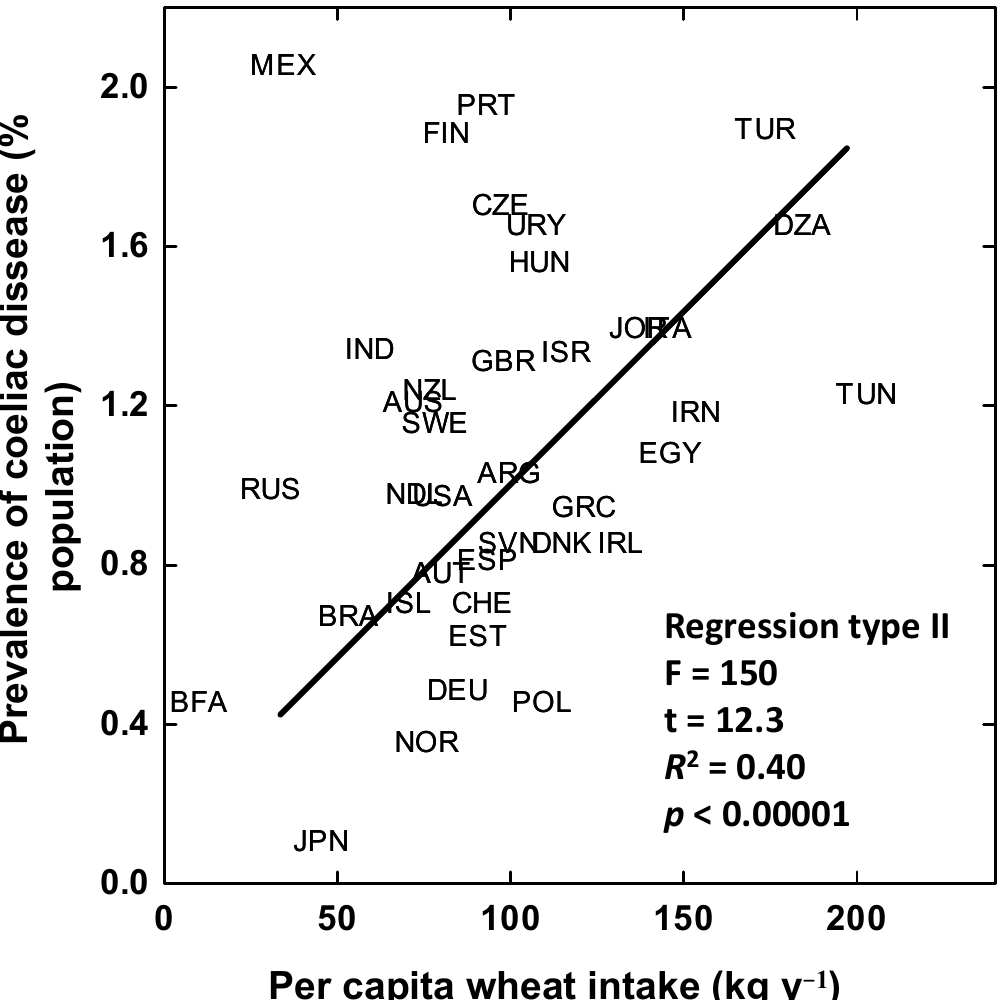
Figure 6. Relationship between the prevalence of coeliac disease and the per capita wheat intakes at country level. DZA = Argelia. ARG = Argentina. AUS = Australia. AUT = Austria. BFA = Burkina Faso. BRA = Brazil. CZE = Czech Republic. DNK = Denmark. EGY = Egypt. EST = Estonia. CUB = Cuba. FIN = Finland. DEU = Germany. GRC = Greece. HUN = Hungary. IND = India. ISL = Iceland. IRN = Iran. IRL = Ireland. ISR = Israel. ITA = Italy. JPN = Japan. MEX = Mexico. NLD = Netherland. NZL = New Zealand. NOR = Norway. POL = Poland. PRT = Portugal. RUS = Russia. SVN = Slovenia. ESP = Spain. SWE = Sweden. CHE = Switzerland. TUN = Tunisia. TUR = Turkey. GRB = United Kingdom. USA = United States of America. URY = Uruguay. Data from [3,15,104–108].